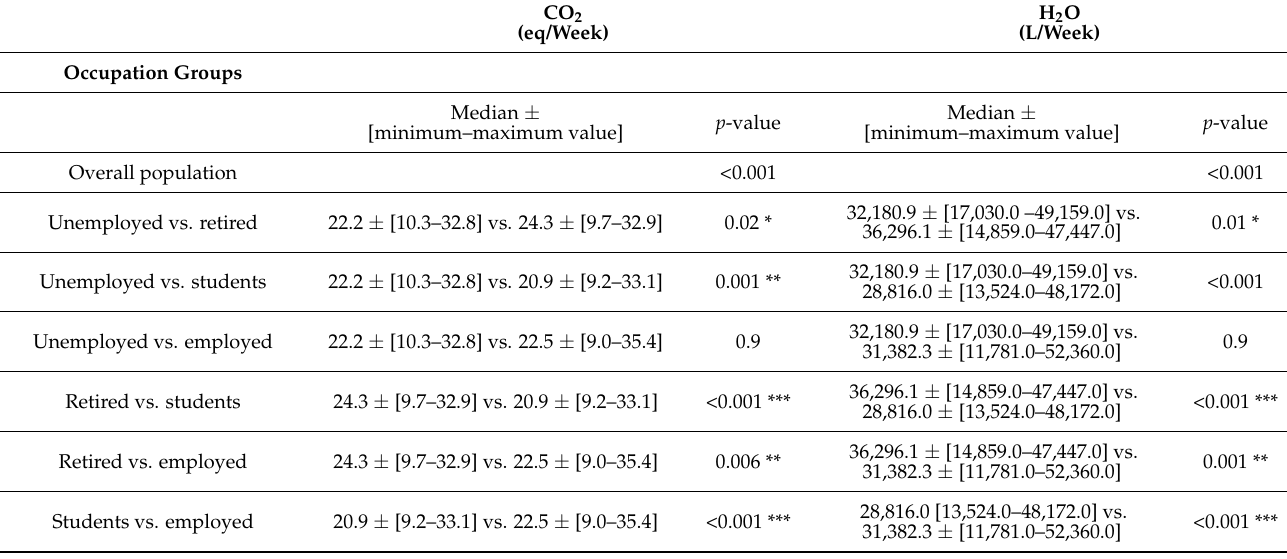
Table 4. Comparisons between the occupation groups for CO 2 and H 2